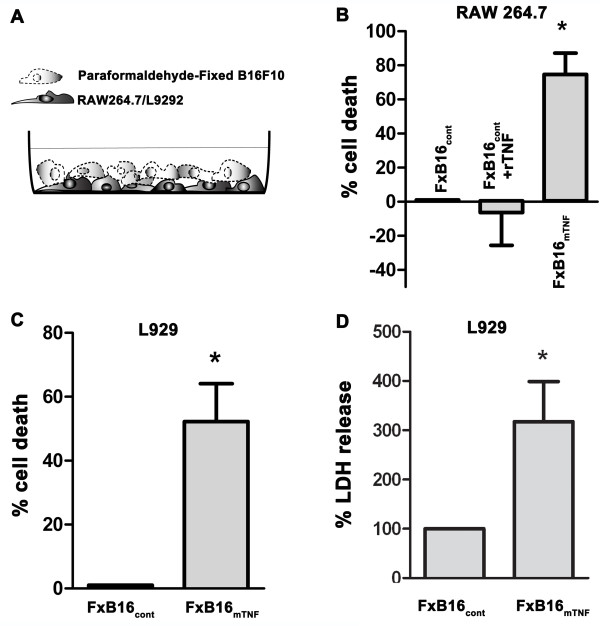
Membrane TNF-α isoform effectively induces cell death. A, Schematic diagram of fixed B16F10 cells cocultured with L929/RAW264.7. B, RAW cells were cocultured with paraformaldehyde-fixed control (FxB16cont), control + rTNFα (FxB16cont + TNFα), or mTNFα (FxB16mTNF) for 24 hours. Cell death was measured by MTT assay. C, MTT assay showing the cytotoxic effects of mTNF-α isoform on L929. D, LDH assay measuring L929 cells percent LDH leakage, in the presence of control or mTNF-expressing fixed B16F10 tumor cells. Data show the percentage of LDH leakage into media to total LDH (media + cells). Each sample was assayed in triplicate, with each experiment repeated at least 3 times independently. Data are expressed as average ± S.E. *P < 0.05 and **P < 0.005, 1-way ANOVA of log (10) transformed data with Student’s t-test as post-test (B), students’s t-test (C and D).